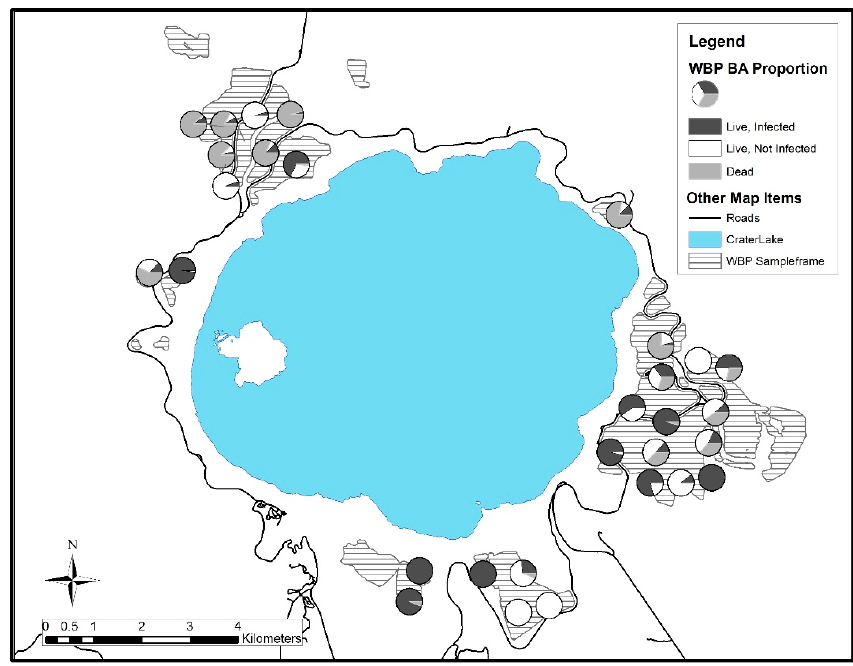
Figure 2. The whitebark pine sampling frame from Crater Lake National Park. Circular symbols show the 30 plots installed between 2012 and 2014, and each symbol is divided into the basal area of whitebark pine that is live, infected with blister rust ( black ), live, not infected with blister rust ( white ), and dead.